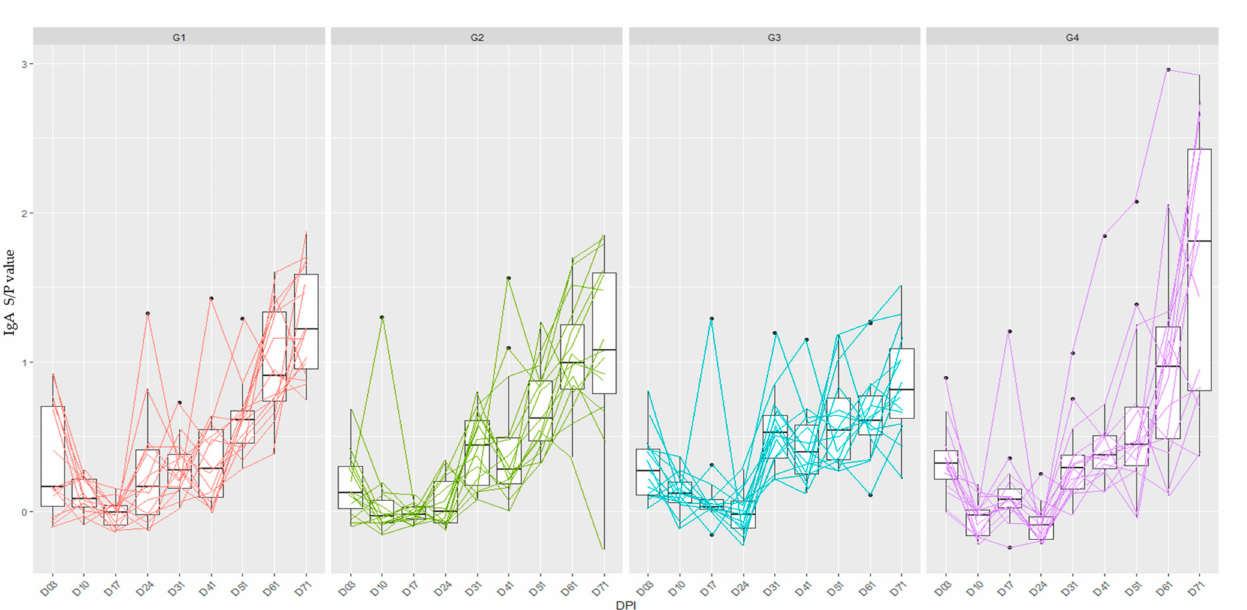
Figure 3. Parallel coordinates boxplots of S/P values for IgA anti- M. hyopneumoniae recorded over time considering animals from G1 to G4. The lines in a parallel coordinates plot represent the trajectories of observations across different time points. The bold dots indicate the outliers.